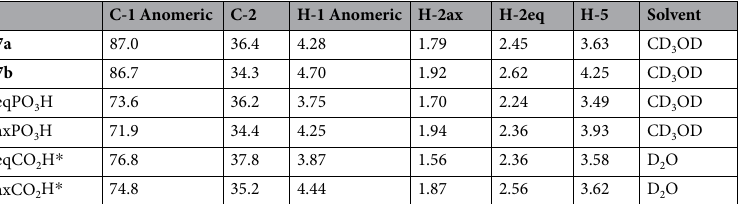
7a 7b 8b eqPO 3 H N1 K i